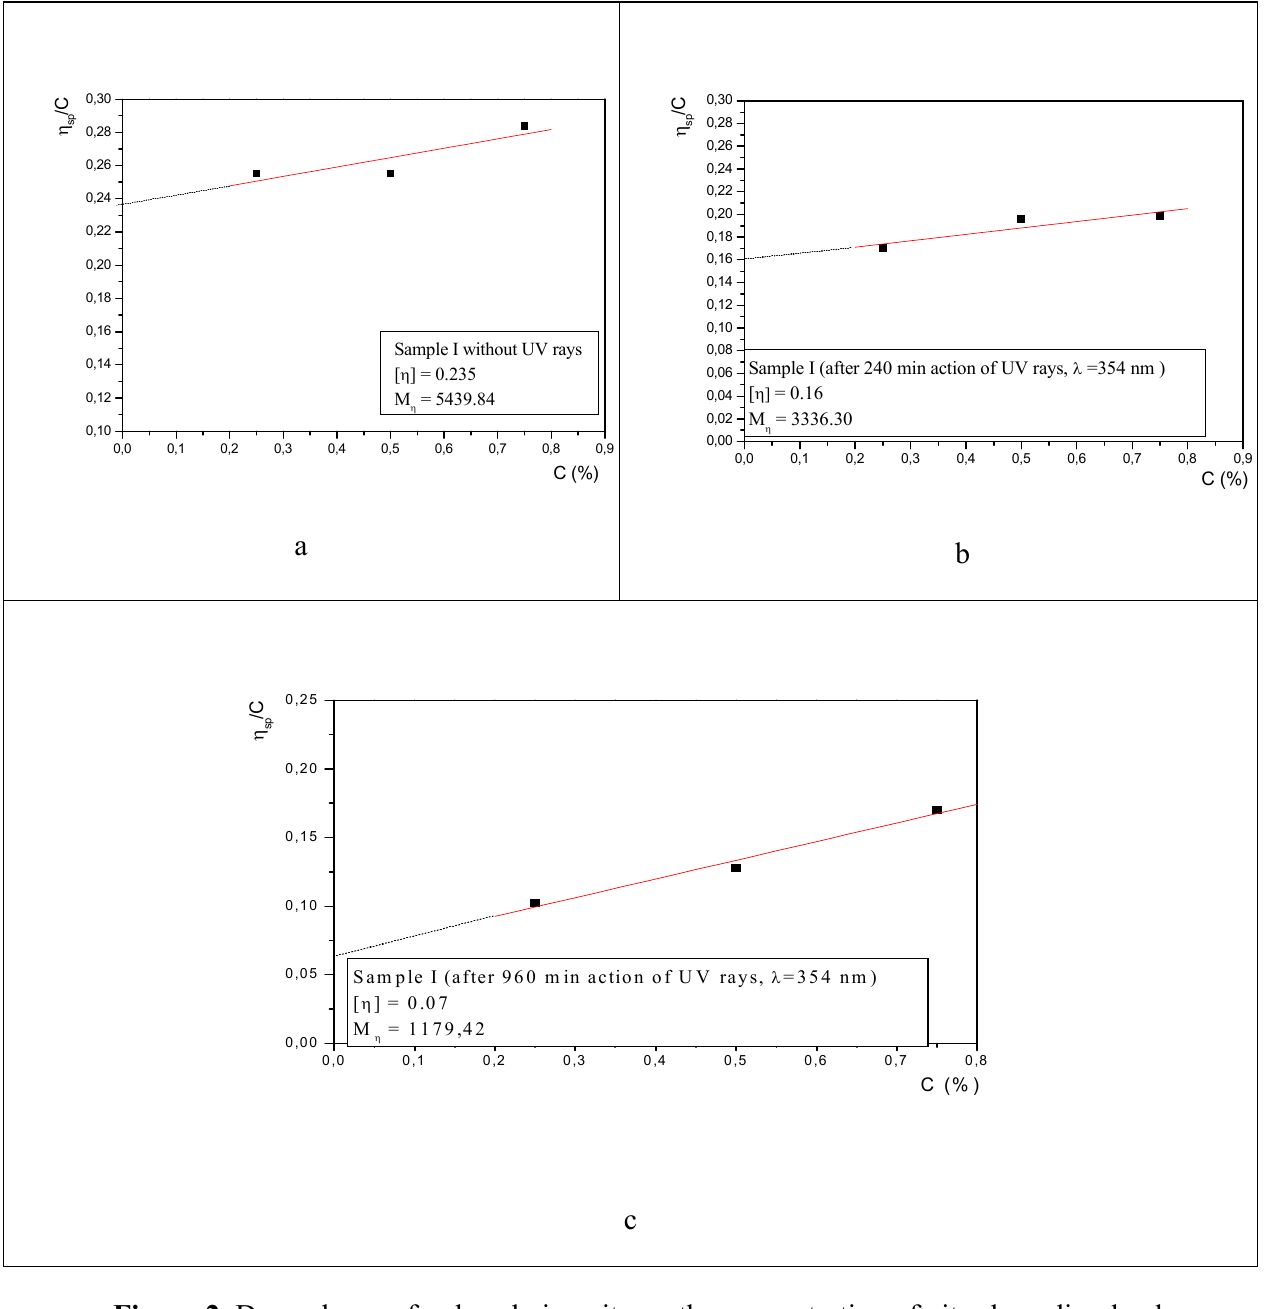
Figure 2 . Dependence of reduced viscosity on the concentration of nitrodope dissolved in acetone, for sample I : a) no action of UV-rays, b) after 40-minute action of UV-rays, c) after 960-minute action of